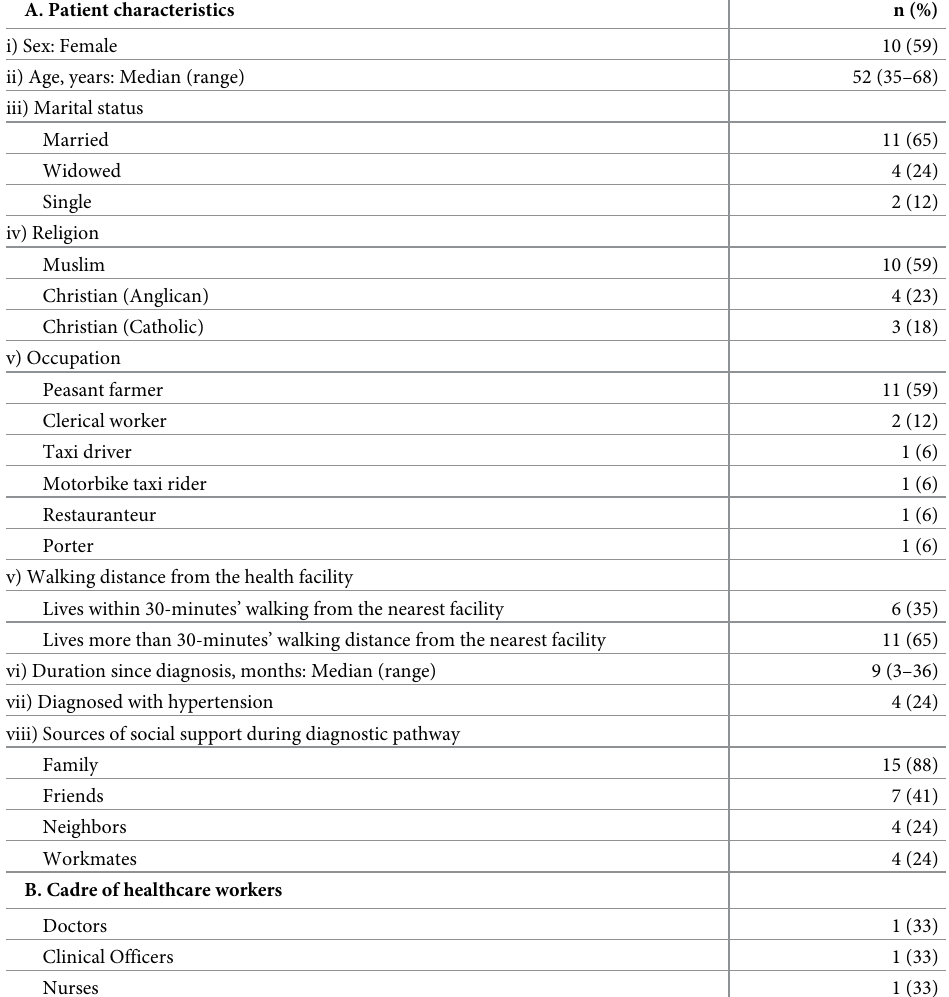
Table 1. Characteristics of the study